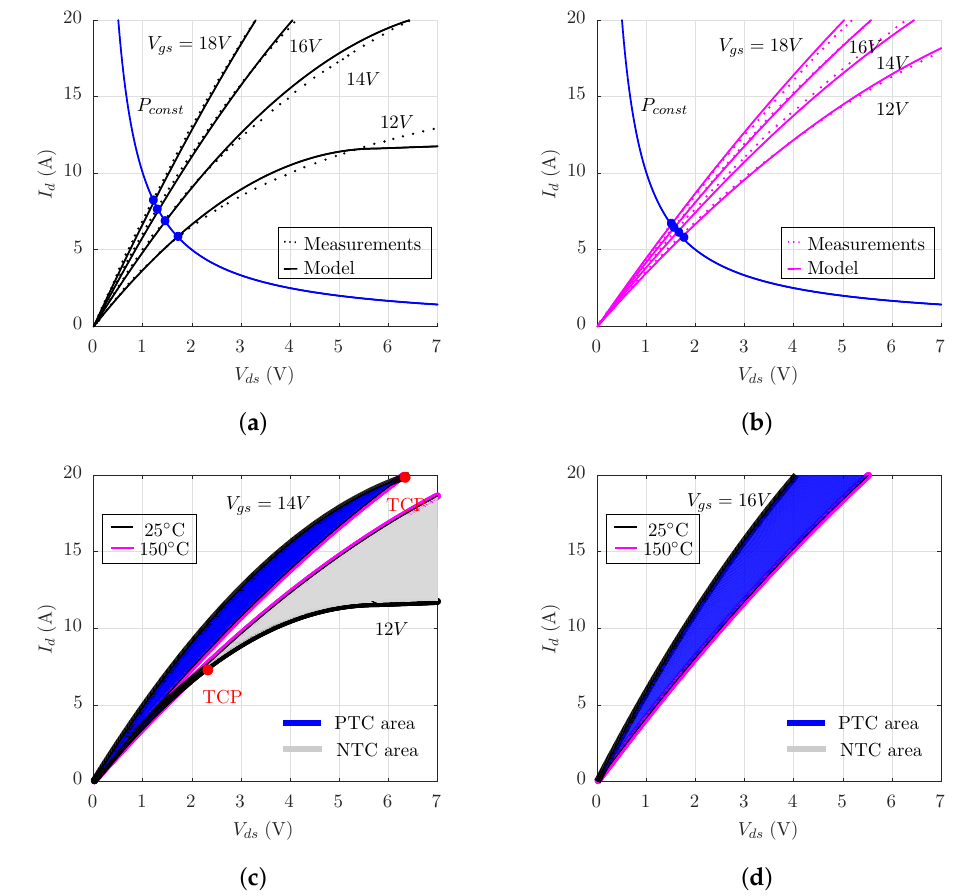
Figure 3. Simulated model and measured IV-characteristics for 1200 V SiC MOSFET at ( a ) 25 ◦ C, ( b ) 150 ◦ C, and NTC and PTC areas at ( c ) gate voltage of 12 V and 14 V, ( d ) gate voltage of 16